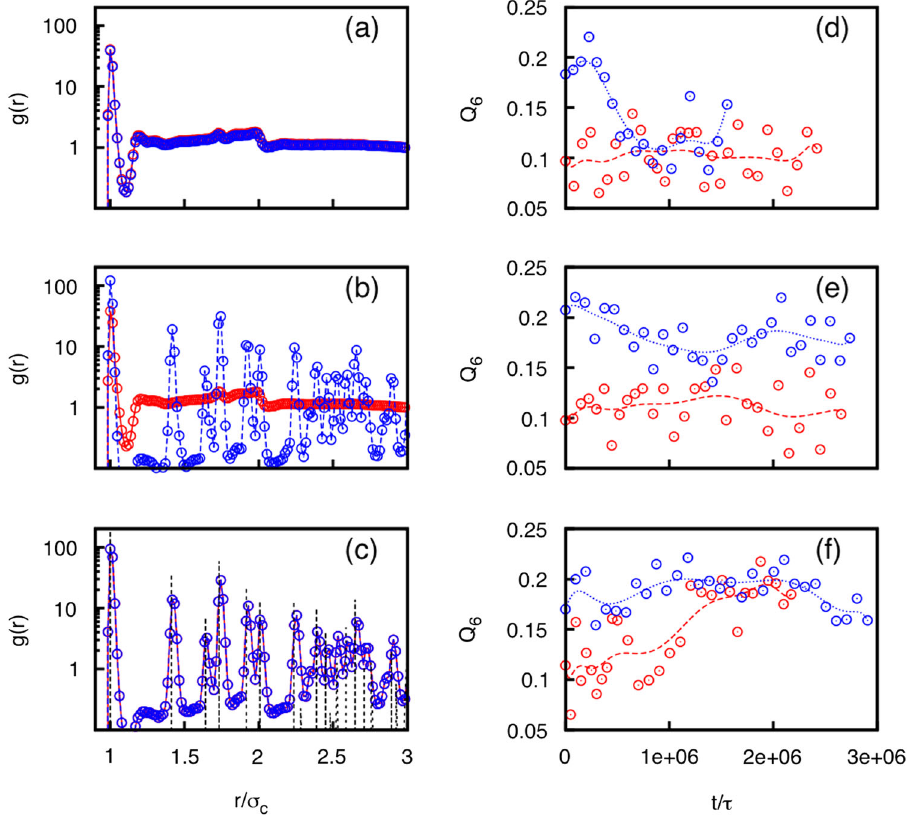
Fig. 2 a – c colloidal radial distribution function g ( r ), and d – f the global bond order parameter Q 6 , obtained from bulk simulations at three polymer densities ϕ p = 0.81 ( bottom ), 0.86 ( middle ) and 0.91 ( top ). The polymer chain length is M = 10 and the colloid volume fraction ϕ C = 0.1. The blue and red points represent results obtained from using two different initial states for simulations, namely an ordered HCP crystal and a disordered structure, respectively. The black dashed lines in c indicate the g ( r ) of a perfect HCP